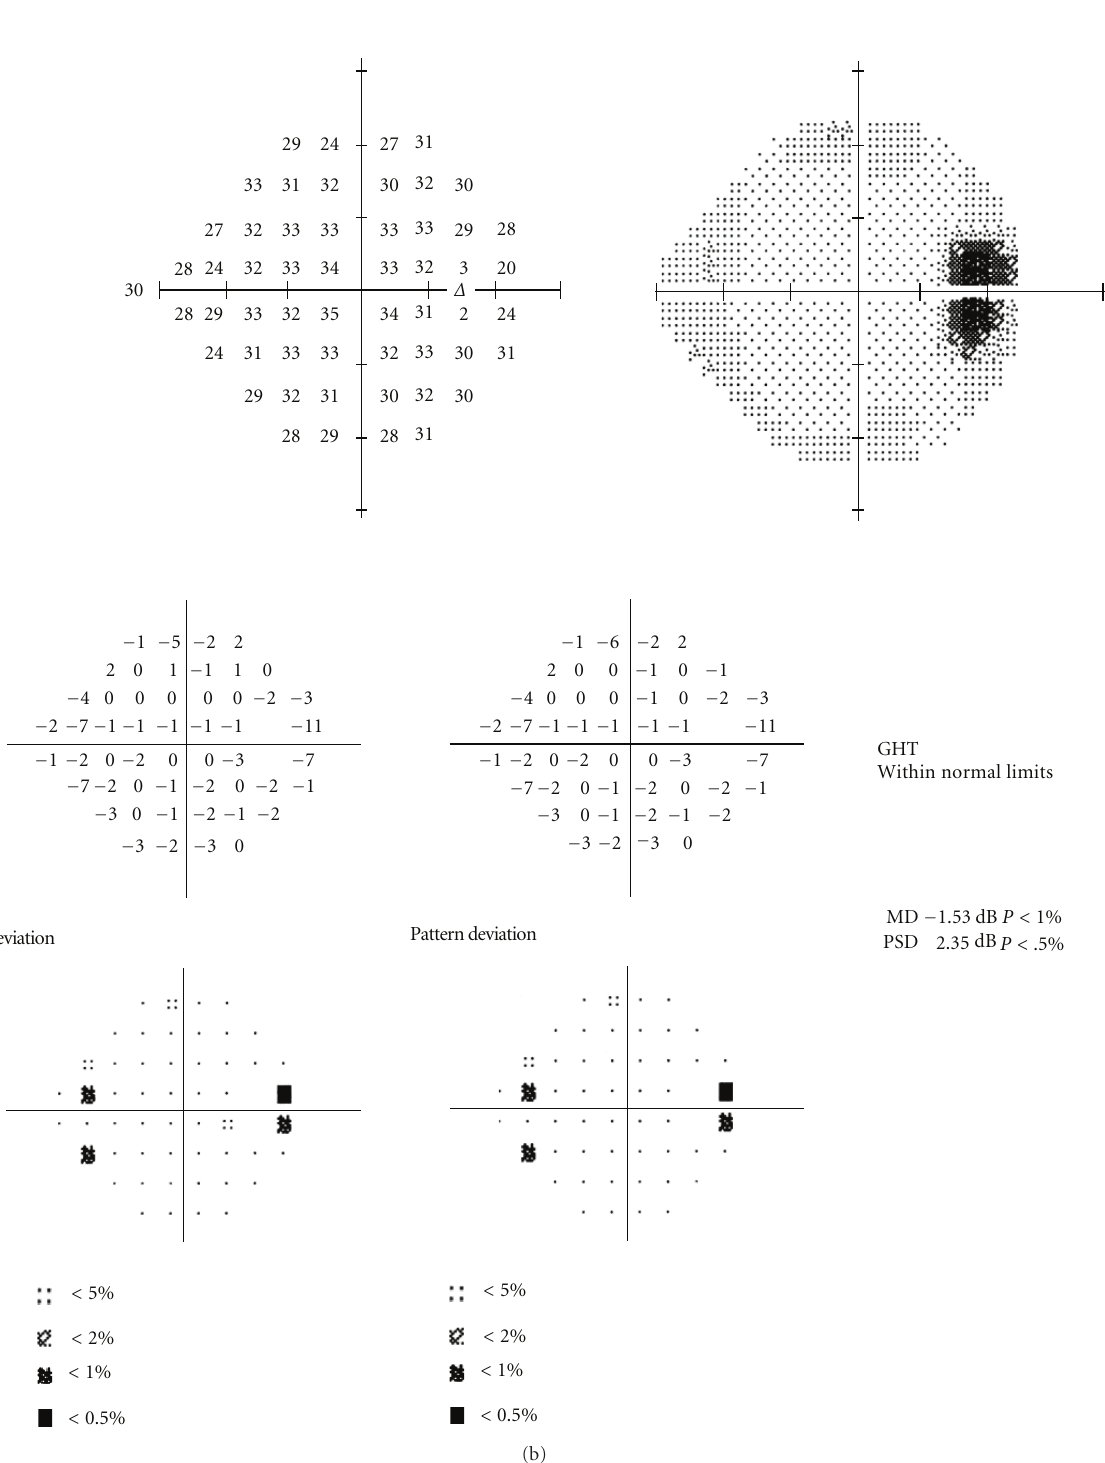
Figure 1: Automated perimetry results, case 1. In the left eye (a), the mean deviation was − 4 . 02 with blind spot enlargement as well as some depression extending toward fixation from the blind spot. In the right eye (b), there was a mean deviation of − 1 . 53 and slight enlargement of the blind